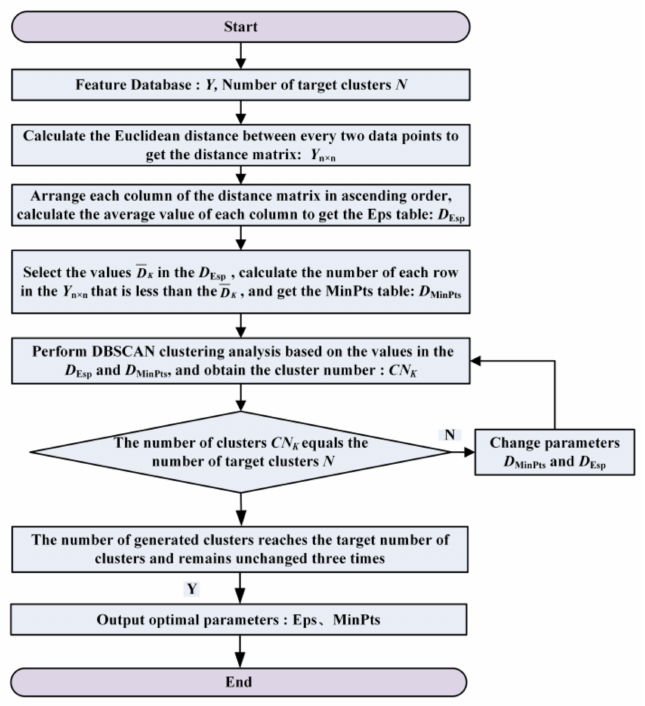
Figure 2. Improved DBSCAN clustering algorithm flow